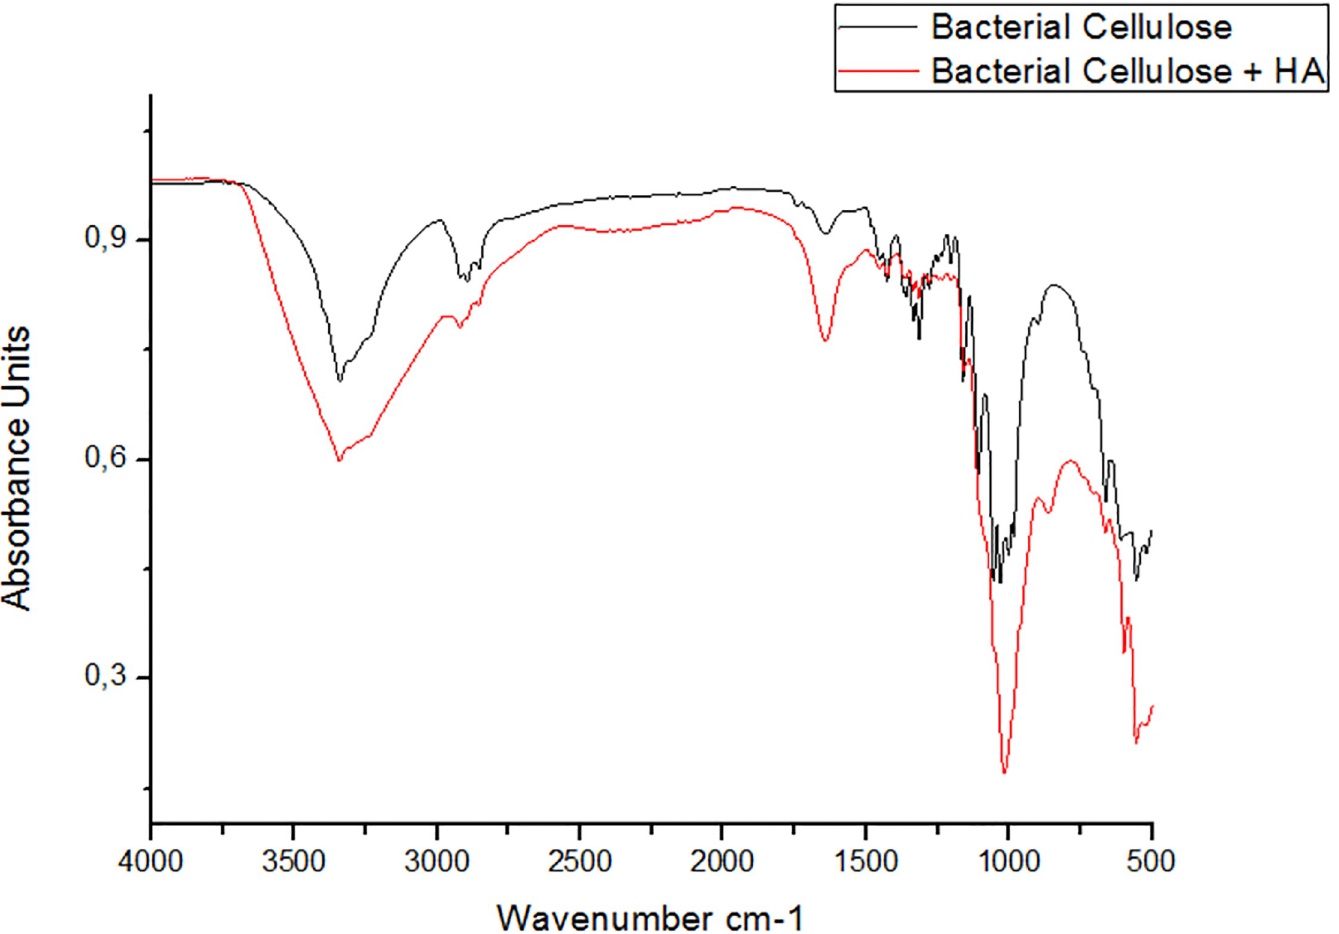
Fig 2. FTIR spectra of BC (black line) and BC-HA (red line).